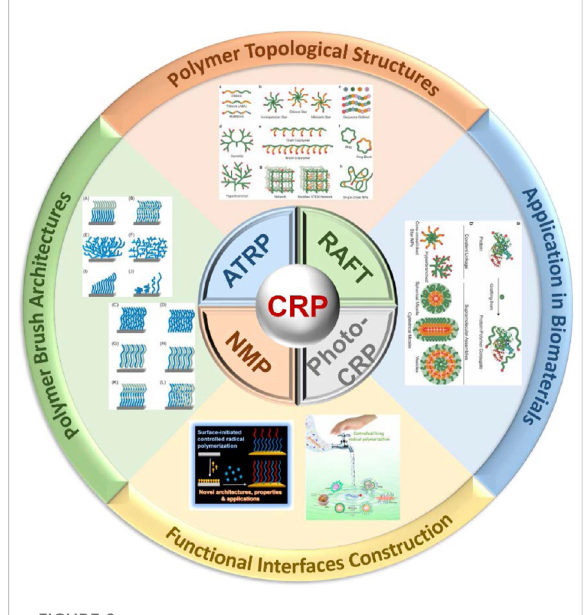
FIGURE 2 Classi fi cation of typical CRPs and different topologies of polymers synthesized by CRP